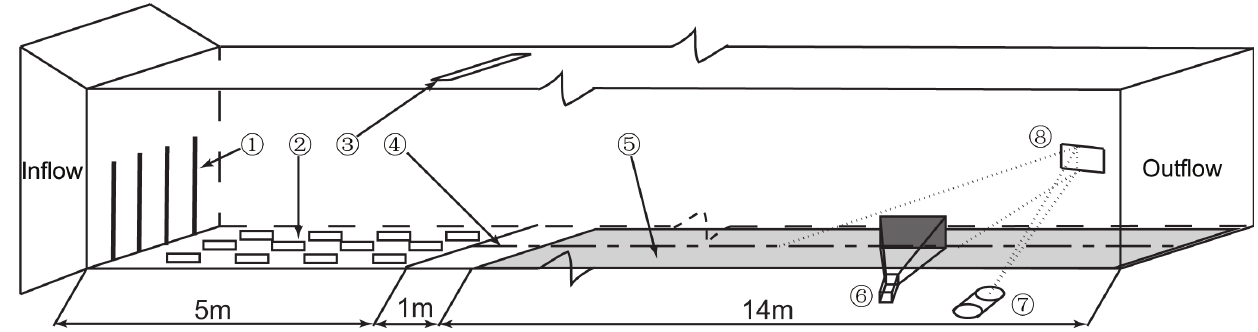
Figure 2. The diagrammatic sketch of wind tunnel experiment design. and are triangular turbulence spires and solid roughness elements respectively. represents the sand supply system. is the central axis line of wind tunnel. , , and represent the sand bed, CCD camera, laser generator and reflecting mirror